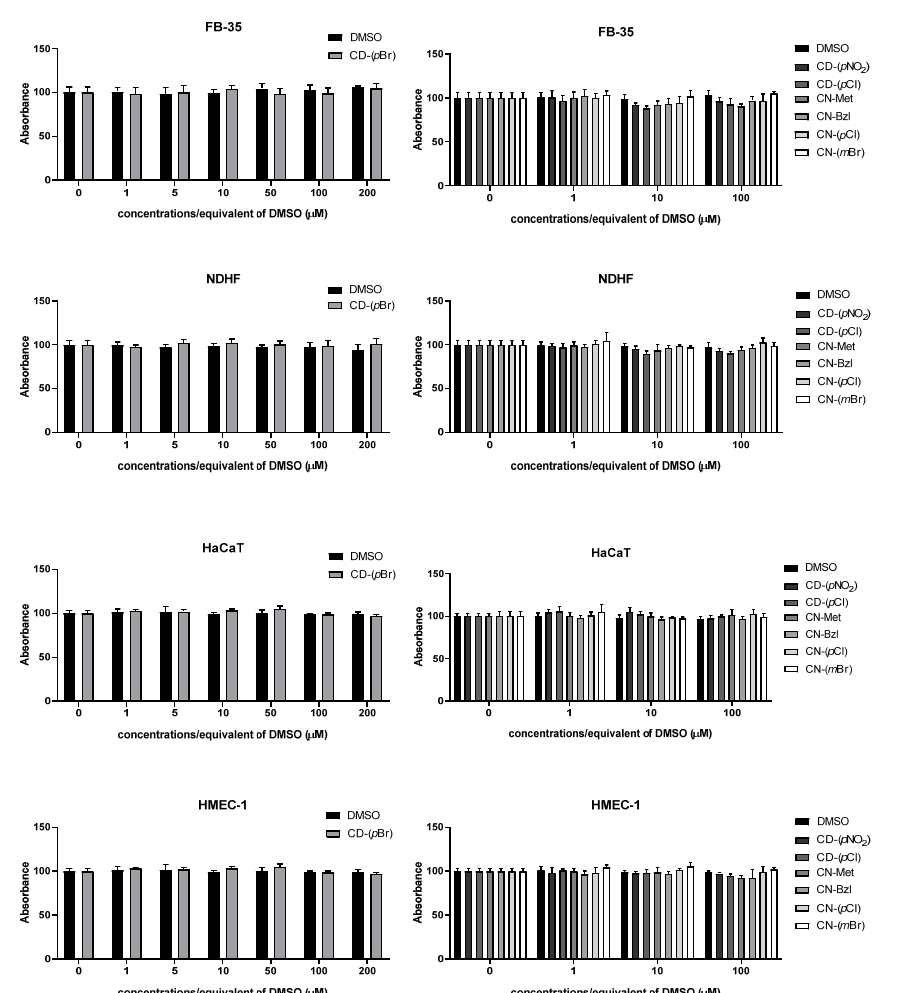
Figure 2. Effects of compounds on FB-35 (normal foreskin fibroblasts), NDFH (normal human dermal fibroblasts), HaCat (keratinocytes), and HMEC-1 (microvascular endothelial cell line) viability. p > 0.05.